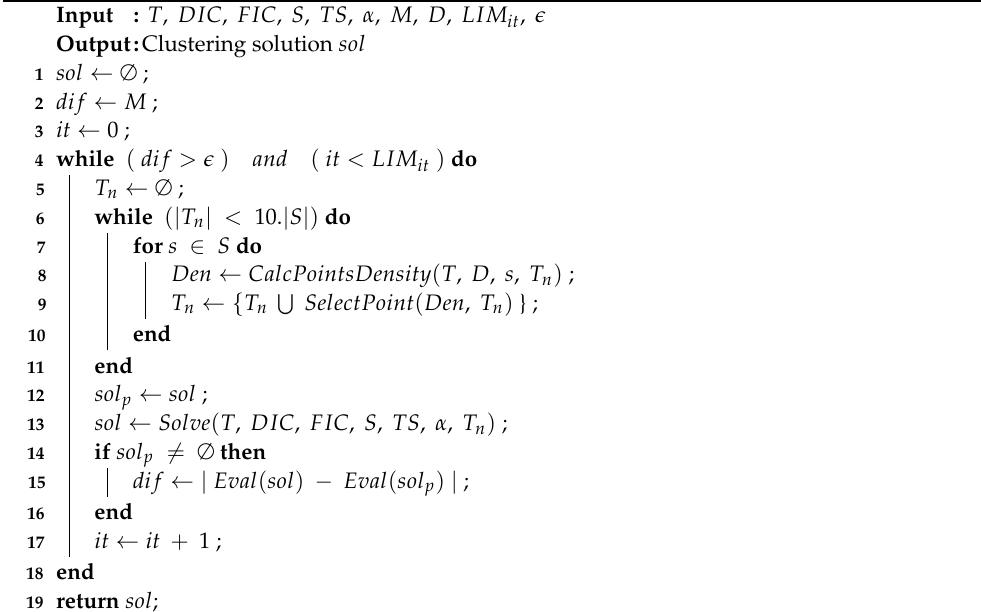
Algorithm 1: The clustering algorithm for electrical